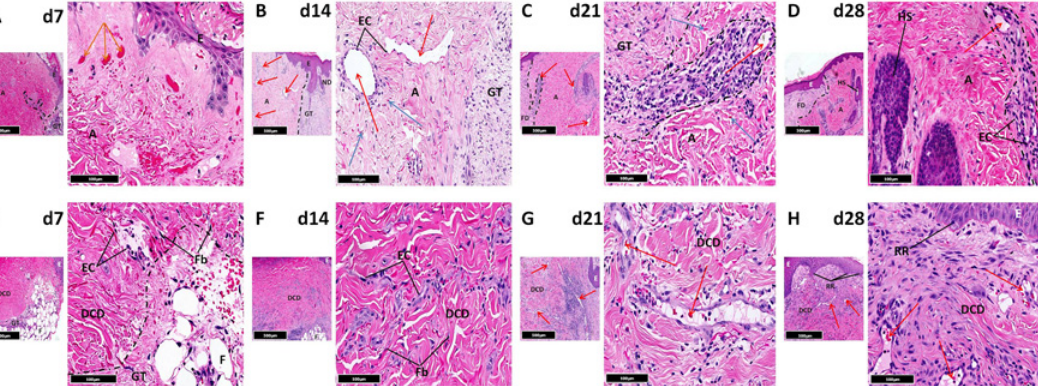
Figure 5. Histological evaluation. Characteristic histological changes in acute cutaneous wounds treated using autografts (2A-D) and DCD (2E-H) focussing on blood vessel distribution and organisation. There is evidence of host migration through defined entry points in both grafted materials promoting revascularisation in autografts and rapid development of capillary networks in DCD. A — autograft, DCD — decellularised dermis, E — epidermis, EC — endothelial cells, Fb — fibroblast, FD — fibrotic dermis, GT — granulation tissue, ND — native dermis, RR — rete ridge. Red arrow — patent vessel lumen, Blue arrow — granulation tissue vessels, Orange arrow — dermal red blood cell extravasation. Black dotted line — border between autograft and host tissue, with finger like projections of inflammatory granulation tissue into autograft or DCD facilitating re-establishment of vascular channels. Smaller image — x5 magnification, larger image — x20